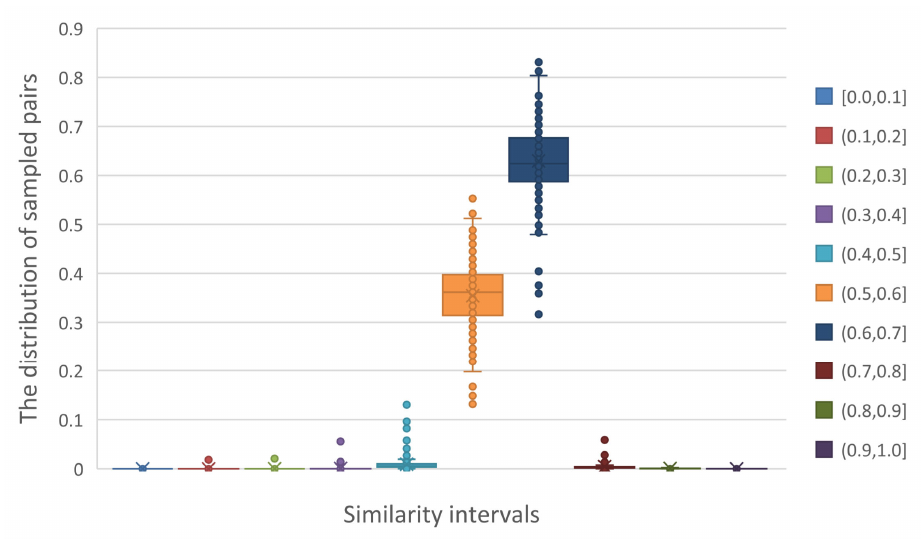
Figure 4. The distribution of sampled pairs on each similarity interval in all datasets.